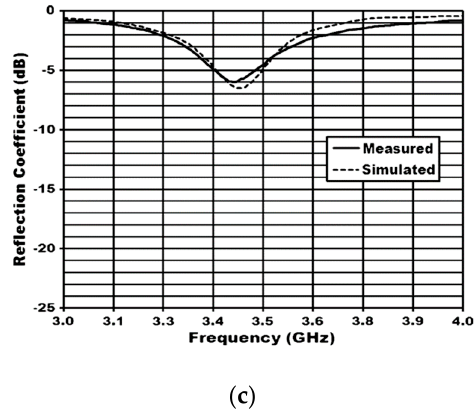
Figure 2. Microstrip patch antenna: ( a ) partially; ( b ) fully filled with EGaIn, inset on left depicting PDMS posts to ensure even liquid filling; and ( c ) simulated and measured response of the microstrip antenna [29].